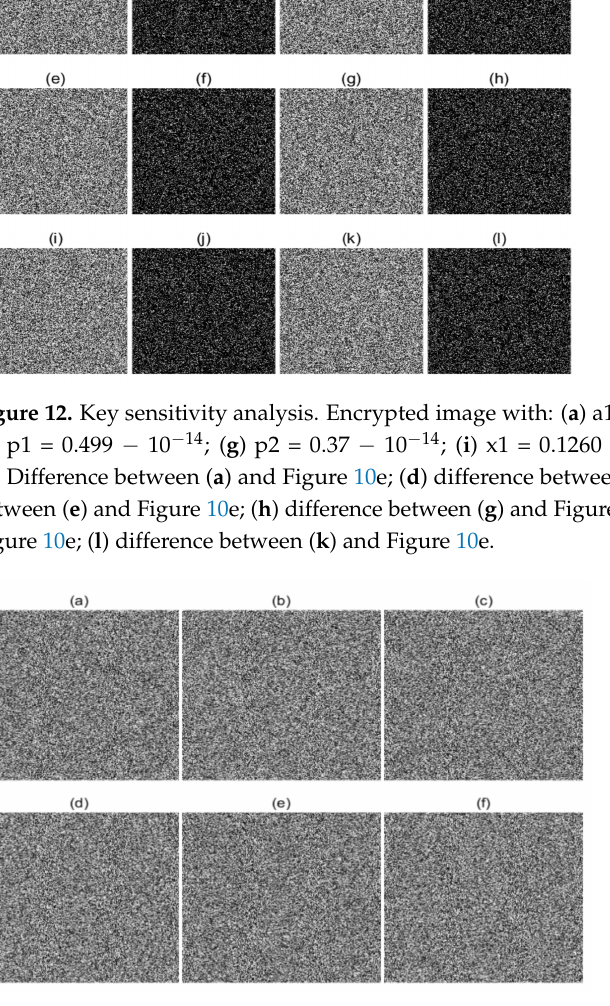
Figure 13. Key sensitivity analysis. Decrypted image with ( a ) a1 = 4 − 10 − 14 ; ( b ) a2 = 3.77 − 10 − 14 ; ( c ) p1 = 0.499 − 10 − 14 ; ( d ) p2 = 0.37 − 10 − 14 ; ( e ) x1 = 0.1260 − 10 − 14 ; ( f ) x2 = 0.3265 − 10 − 14